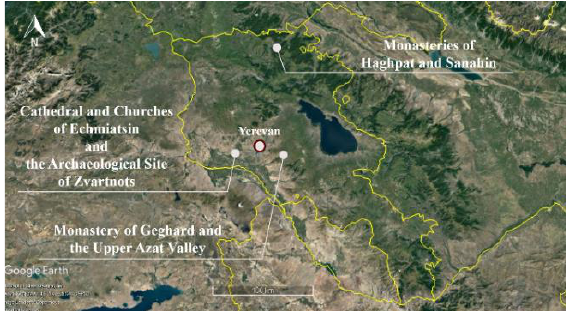
Figure 1. Location map of the Apostolic World Heritage